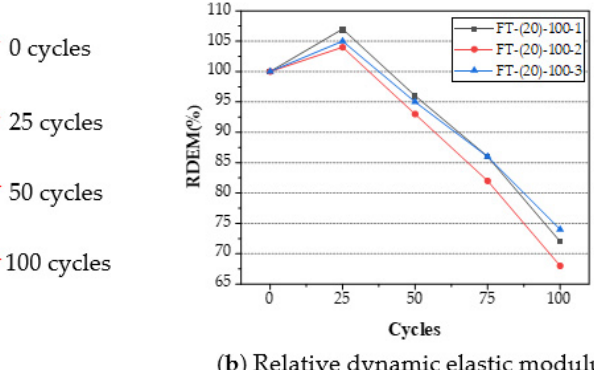
Figure 5. Measuring points of three-point beading test at 20 °C. ( a ) 20 °C Front. ( b ) − 20 °C Back. Two strain gauges were symmetrically pasted at the left and right sides of the front of the initial notch, and each strain gauge had a horizontal distance 5 mm away from the crack tip. Each measuring point data was recorded by a half-bridge, consisting of a work- ing and compensation strain gauge. The strain changes of ECC in fracture tip areas were detected to determine the cracking load [33]. The clip-on extensometer, with a range of ±10 mm, records the crack mouth opening displacement (CMOD), and the clip-on extensometer with a range of ±5 mm records the crack tip opening displacement (CTOD). 2.4.2. The 0, − 20, and − 60 °C Mode I Fracture Test Setup The temperature dropping specimen and temperature control specimen of the inter- nally-embedded temperature sensor were made of the same size and material as the load- ing specimen. Then, the temperature control, temperature dropping, and loading speci- mens were cooled in the refrigerator, with an operating temperature of 20~ − 80 °C, devel- oped by Suzhou Jiang Kai Machinery Equipment Co., Ltd. (Suzhou, China). A tempera- ture control recorder was used to ensure that the central temperature of the temperature control specimen dropped to the experimental temperature. After that, the temperature dropping specimen was moved into the self-made insulation can to precool the loading environment and minimize the temperature loss during the experiment. As the tempera- ture in the insulation can was lowered, the loading specimen was moved into the insula- tion can to be loaded. Cooling system and low temperature test setup (0, − 20, and − 60 °C) are shown in Figure 6.